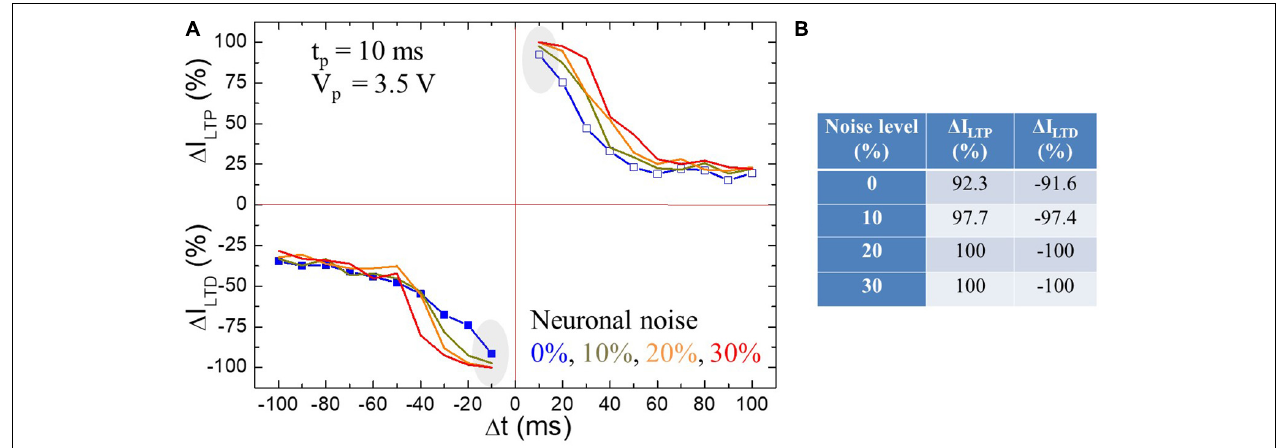
FIGURE 7 | (A) Impact of triangle neuronal noise with different noise amplitudes V nn , i.e., V nn = 0 V (blue line), 0.35 V (dark yellow line), 0.70 V (orange line), and 1.05 V (red line) at f nn = 593 Hz on STDP learning functions in BFO artificial synapse. The STDP diagram has been recorded with pulse width t p = 10 ms (i.e., learning window of τ = 25 ms) and pulse amplitude V p = 3.50 V. The measurement waiting time is defined as t w = 2 s. (B) Illustration of the experimental recorded normalized LTP/LTD current (cid:49) I LTP / (cid:49) I LTD at | (cid:49) t | = t p = 10 ms (gray marked) at neuronal noise level of 0, 10, 20, and